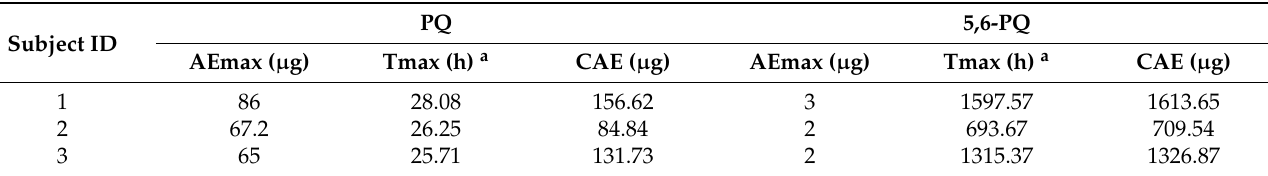
Table 4. Pharmacokinetic parameters of PQ and 5,6-PQ in human urine ( n = 3).